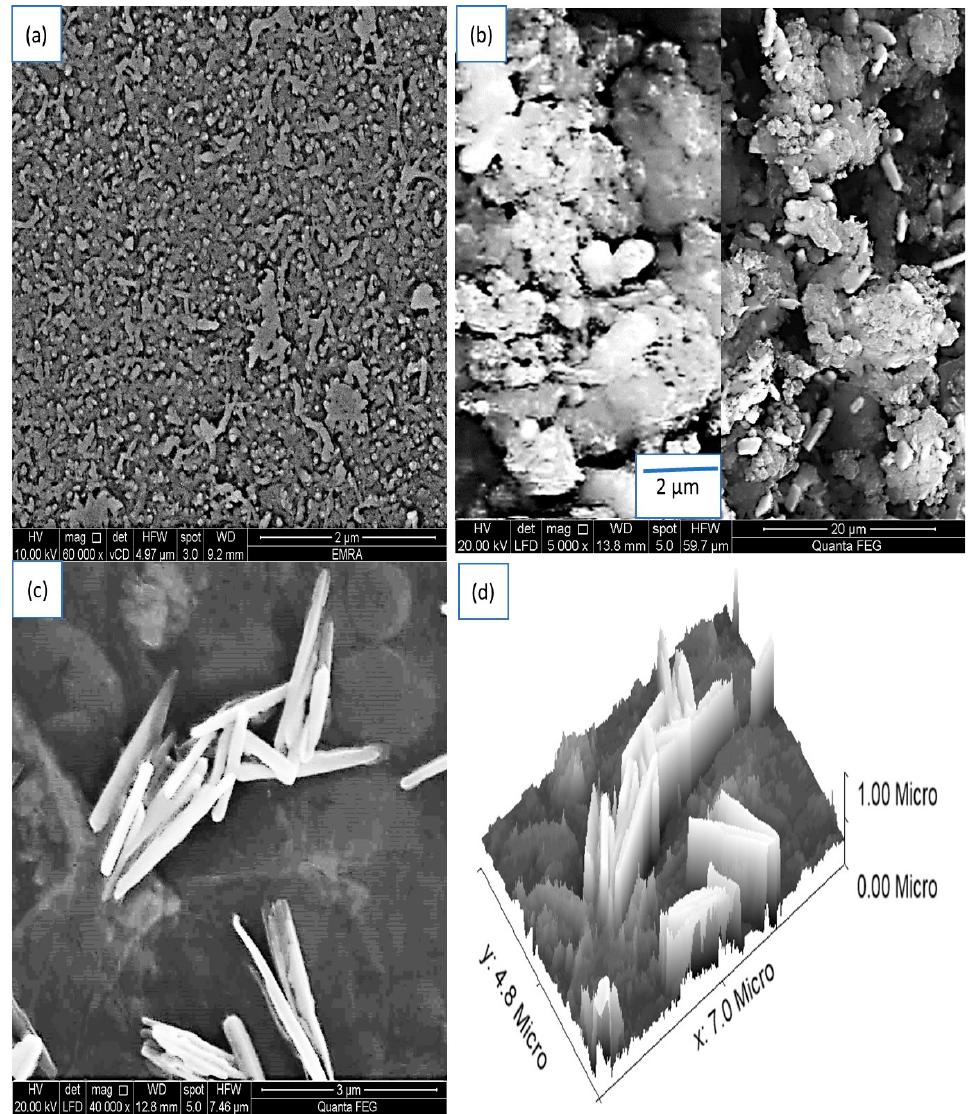
Figure 2. The SEM of ( a ) PANI, ( b , c ) roll-GO/PANI face image for powder and film, respectively, and ( d ) theoretical simulation face and cross-section of roll-GO/PANI film.